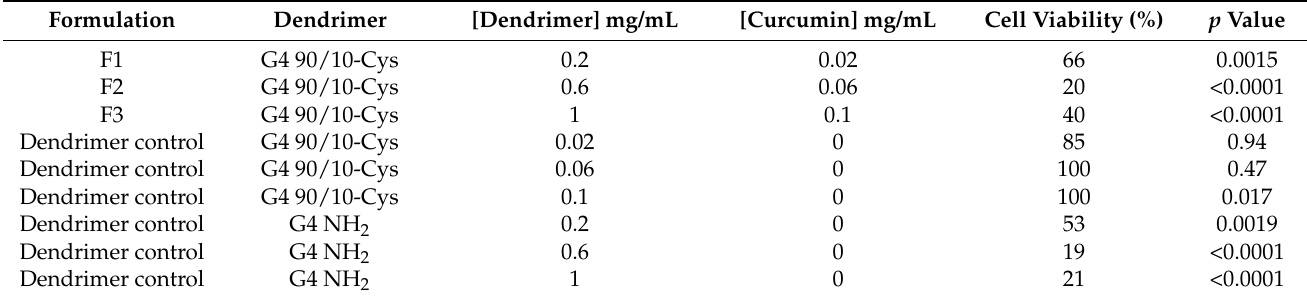
Table 4. Effect of F1, F2 and F3 and on F98 cells.